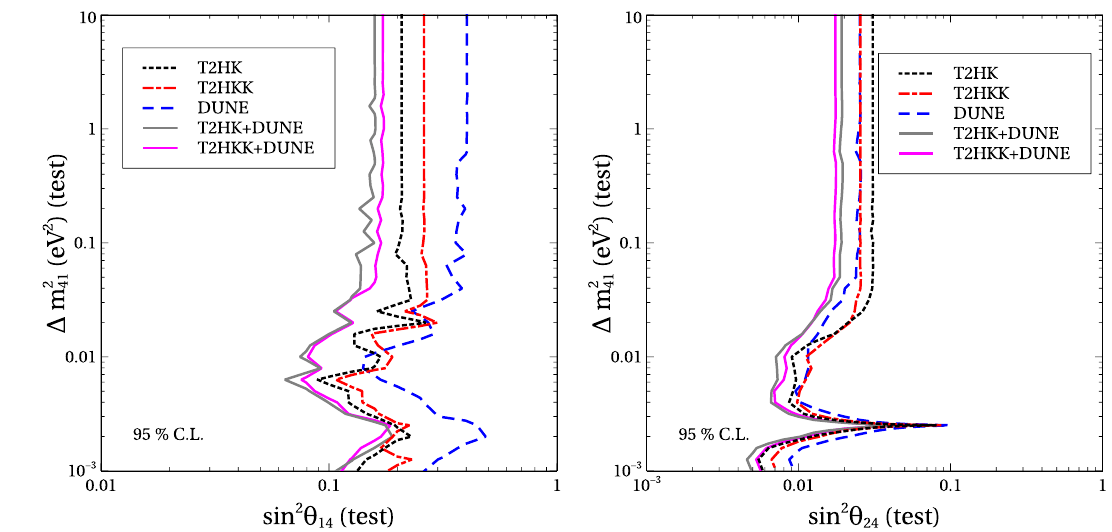
Fig. 7 The expected 95% C.L exclusion curves in the sin 2 θ 14 (test)- (cid:5) m 2 (test) plane shown in the left panel and in the sin 2 θ 24 (test)- 41 (cid:5) m 2 (test) plane shown in the right panel. The data in these plots 41